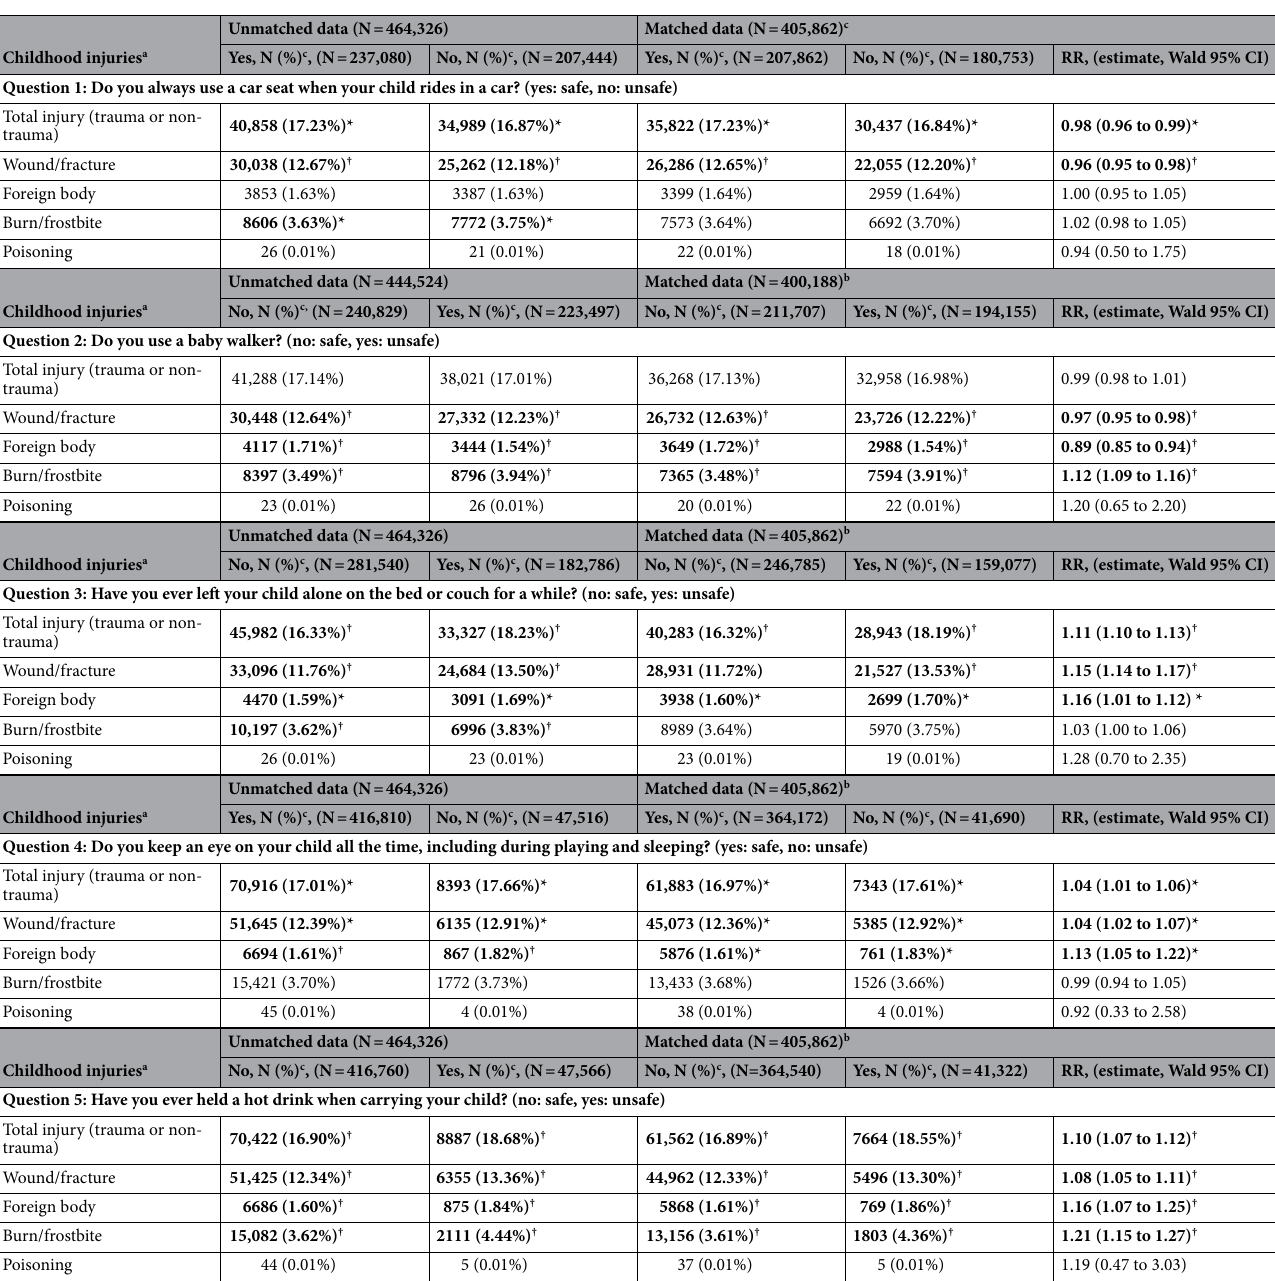
Table 3. Risk ratios for injury in children aged 4 to 12 months according to five questionnaire items (sensitivity analysis). N number, CI confidence interval. Unless otherwise specified, all diagnoses of childhood were assessed at eh age of 4 to 12 months (after the first, and before the second round of the NHSPIC). a Diagnosis of childhood injuries was based on ICD-10 codes (Supplementary Appendix 2). b Matched using inverse probability of exposure matching, based on propensity scores. The propensity score was estimated using multivariable logistic regression with covariates chosen a priori (Table S2). c Values are reported as N (%) unless otherwise indicated. * p < 0.05, † p < 0.001. Significant values are in